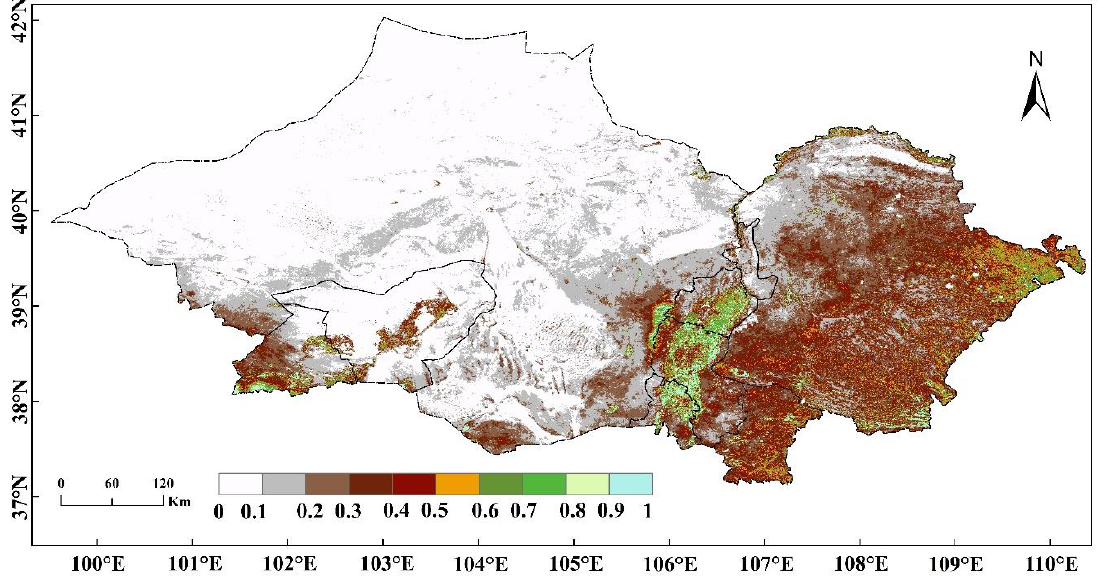
Figure 8. Spatial distribution of CFVC M in the study area. The colour bar shows the level of CFVC M divided into 10 levels at intervals of 0.1.